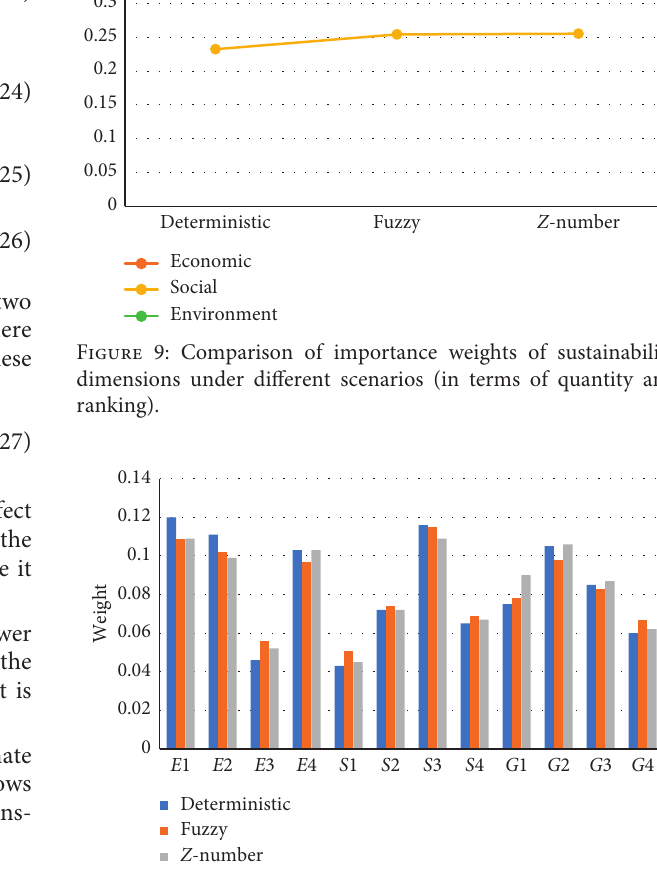
Figure 10: Comparison of importance weights of sustainability criteria under different scenarios (in terms of weight